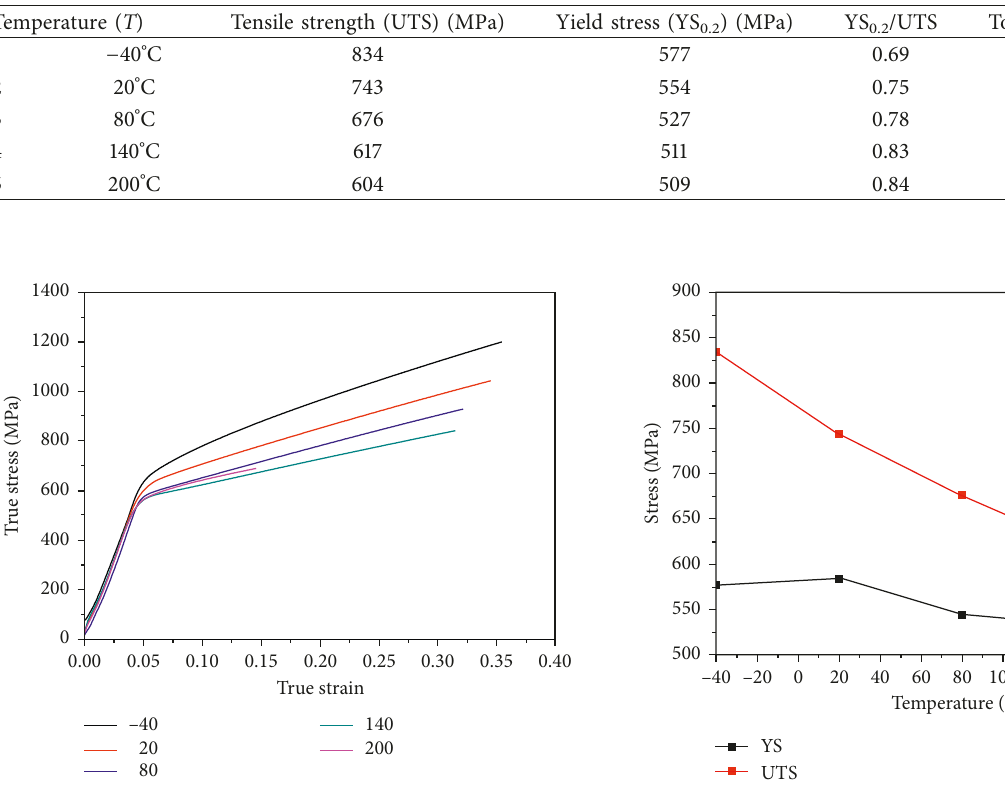
Figure 4: Mechanical properties of the X6MnSiAlNbTi26-3-3 steel: yield stress (YS) and ultimate tensile strength (UTS) at various tensile test